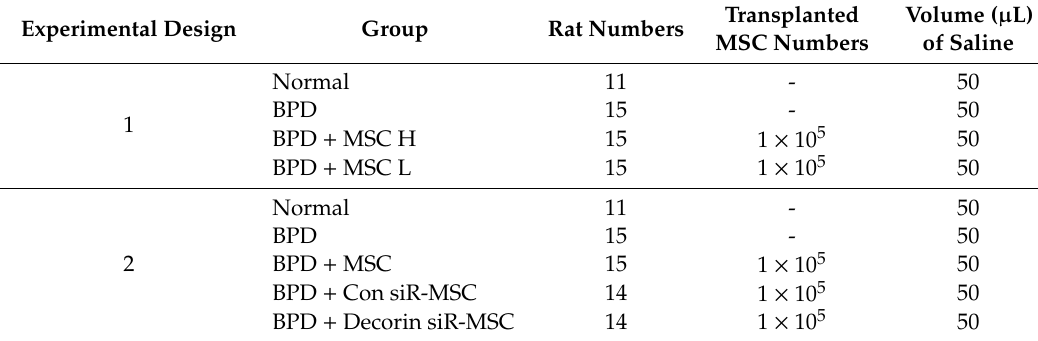
Table 2. Experimental design in